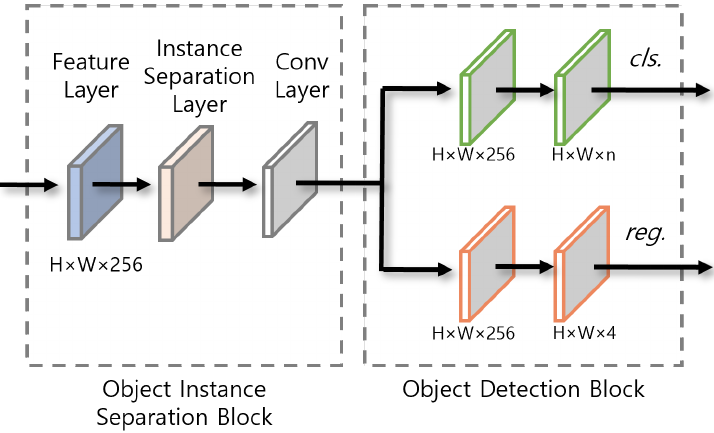
Figure 4. Prediction